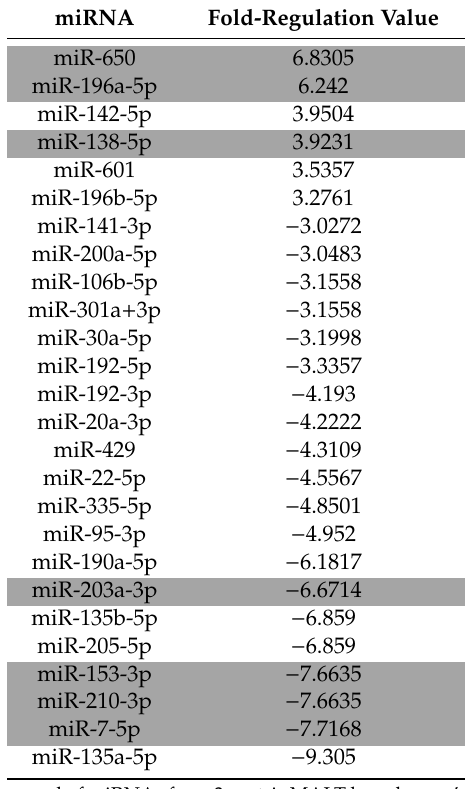
Table 1. Deregulated miRNAs in gastric MALT lymphomas compared to gastritis.